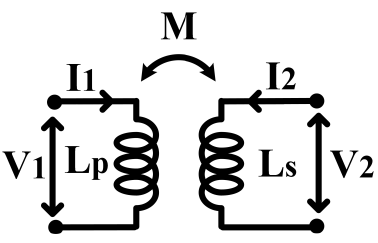
Figure 9. Schematic of the TVB.